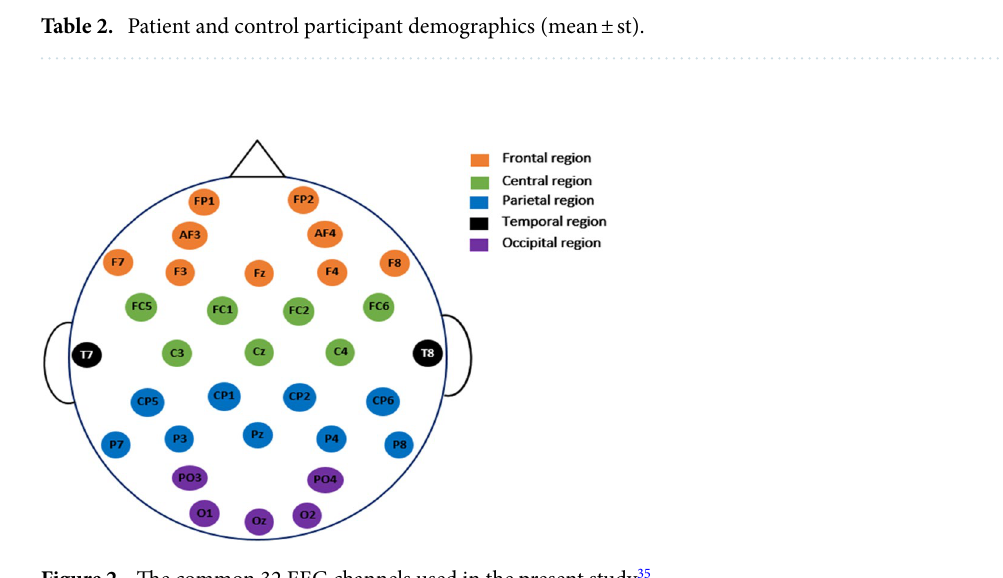
Figure 2. The common 32 EEG channels used in the present study 35